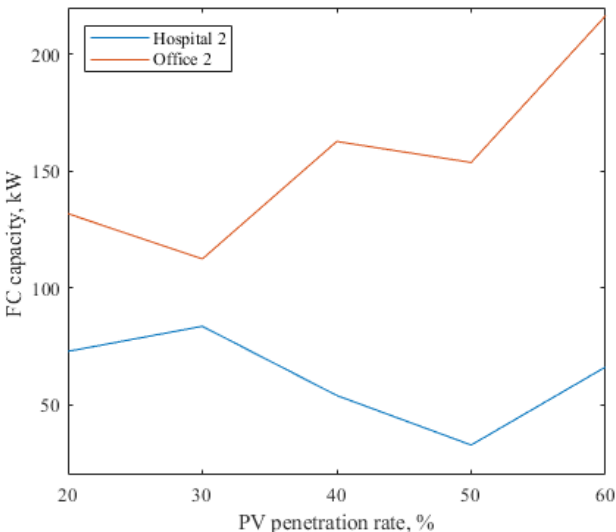
Figure 11. Reduce proportion of RDHES in ten buildings under different PV penetration.